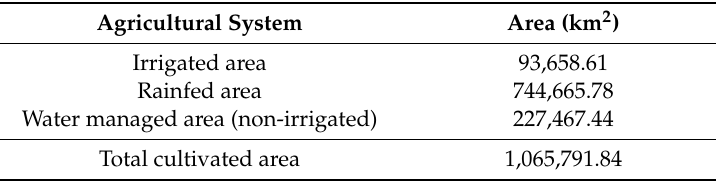
Table 1. Land area of agricultural systems in Southern